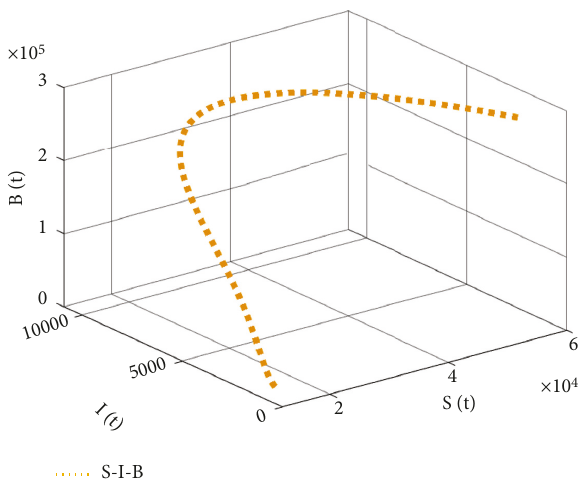
Figure 14: Simulation of S(t) , I(t) , and B(t)